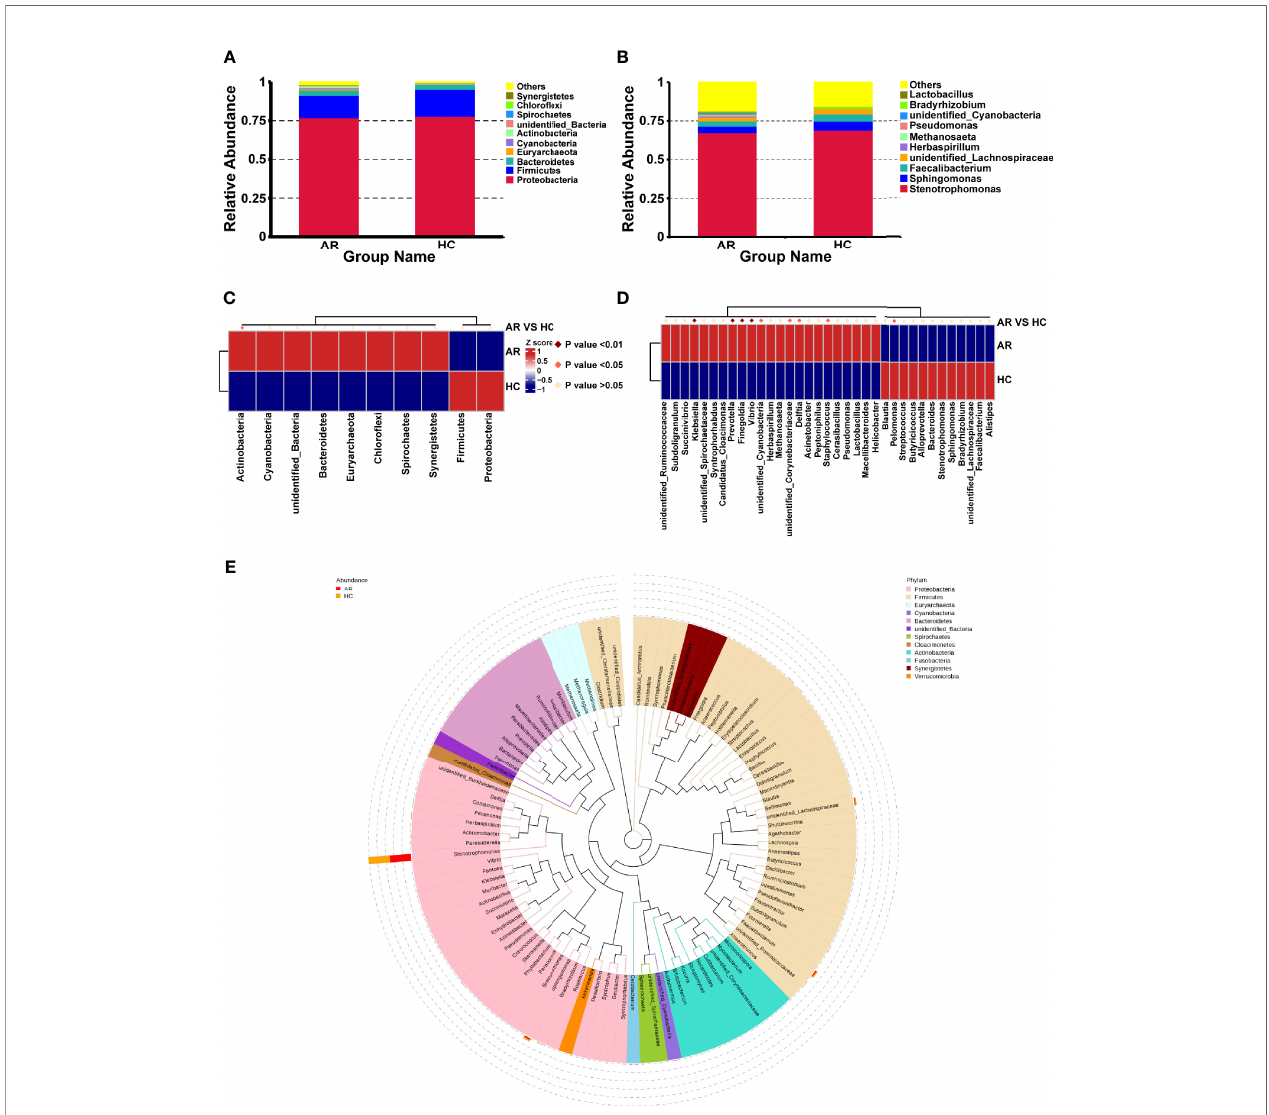
FIGURE 3 | The distribution of taxa in phylum and genus levels of AR and HC groups. (A) composition of microbiome at the phylum level. (B) composition of microbiome at the genus level. (C) the statistical results of top 10 phyla. (D) the statistical results of top 35 genera. (E) Phylogenetic tree constructed from representative sequences of genus-level species, with branch and fan colors indicating their corresponding gates, and stacked histograms outside the fan rings indicating information on the abundance distribution of the genus in different